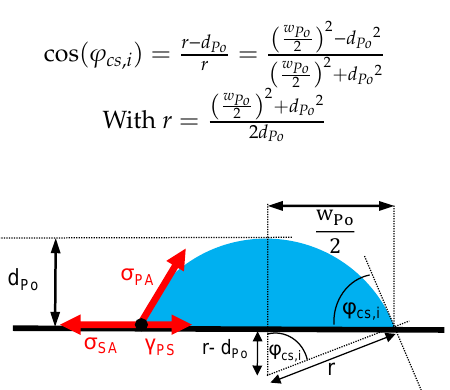
Figure 10. Schematic cross section of the polymer trace in the form of a cylinder segment.